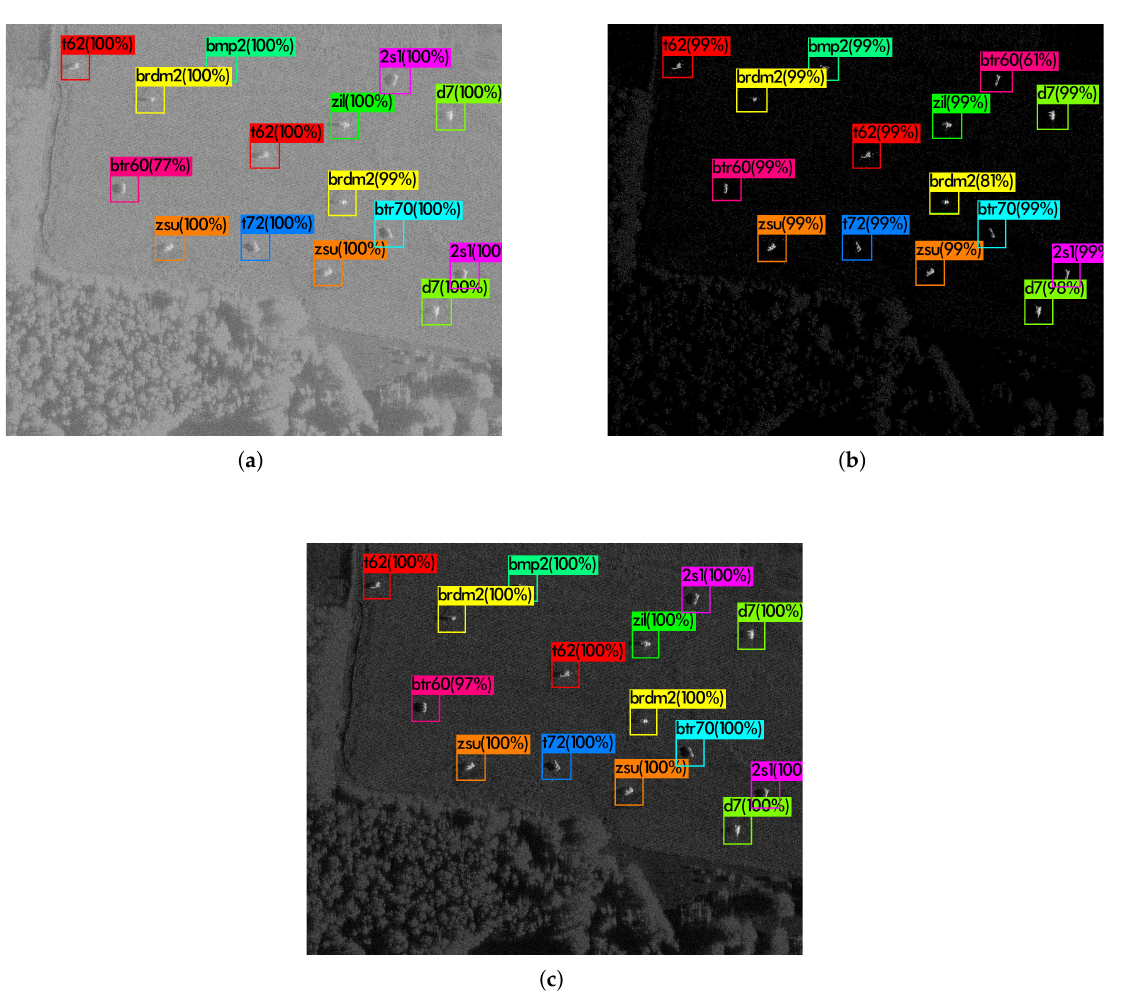
Figure 8. The presentation of target detection under SOC by using different datasets. ( a ) MF dataset. ( b ) ˆX C dataset. ( c ) ˜X C